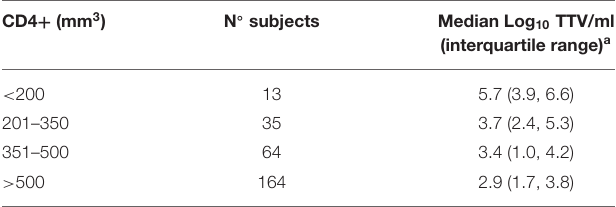
TABLE 2 | Association between CD4 + cell count and TTV in saliva.